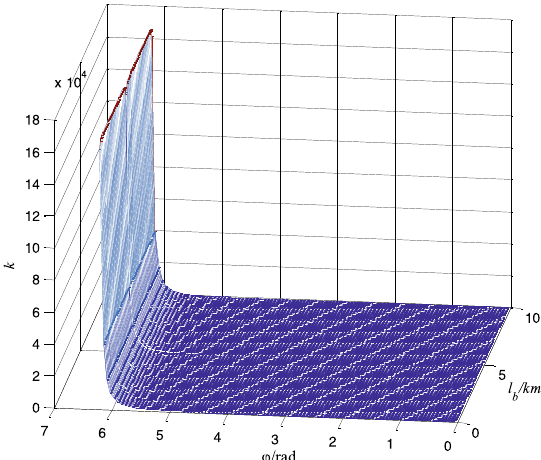
Fig. 2 Three-dimensional surface map of amplitude ratio